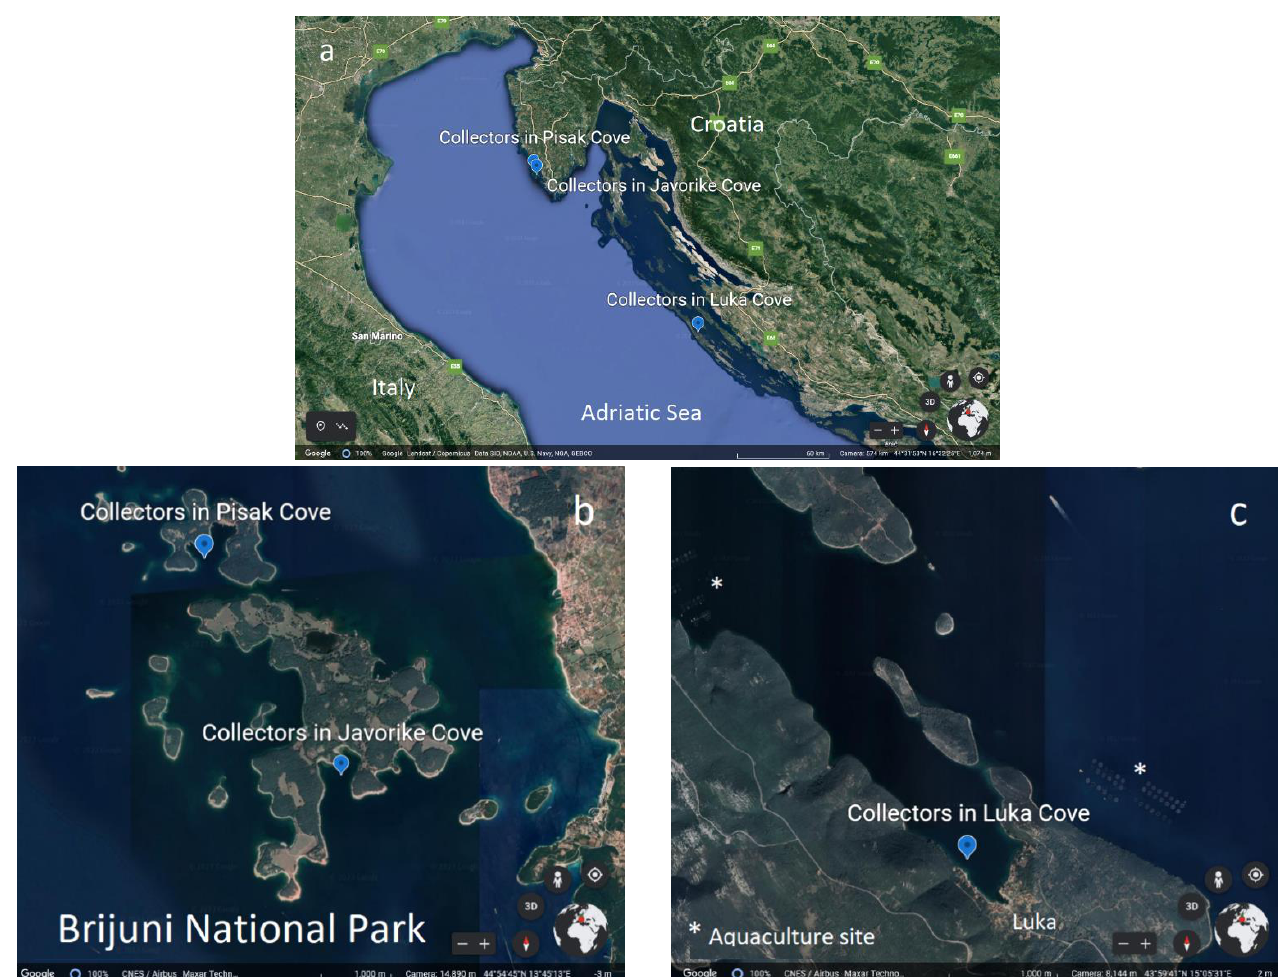
Figure 1. Locations of study sites. ( a )—a general position in the Adriatic Sea, ( b )—locations in Javorike and Pisak Coves within Brijuni National Park, ( c )—location in Luka Cove, Central Adriatic (two nearby aquaculture sites are marked with an asterisk).